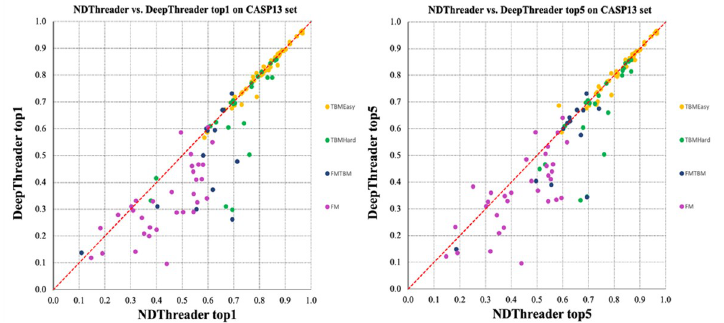
Fig 5. Head-to-head comparison between NDThreader and DeepThreader on the CASP13 targets. Left: top 1 models. Right: the best of top 5 models. Each point represents the quality (TM-score) of two models generated by NDThreader (x-axis) and DeepThreader (y-axis),